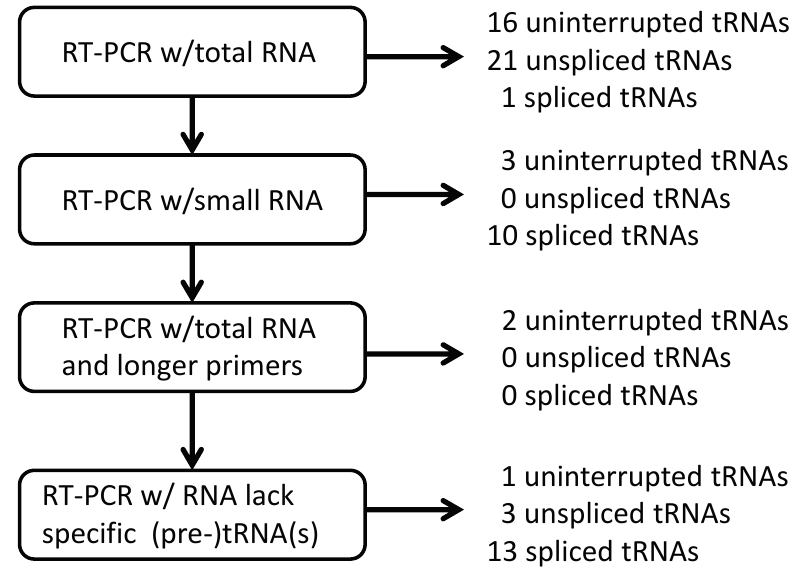
Figure 6. Overall strategy used to clone cDNAs that represent actual S. tokodaii tRNAs